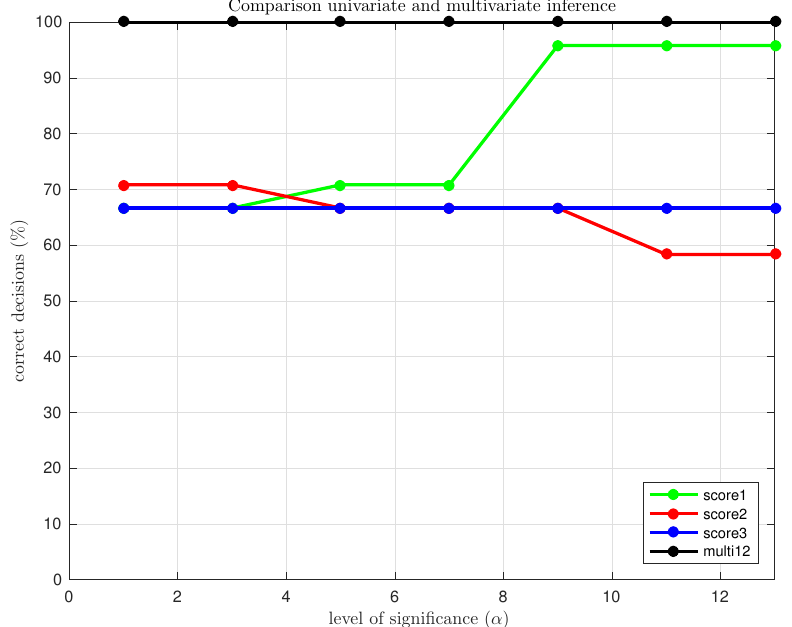
Figure 6. Percentage of correct decisions using the multivariate hypothesis testing fault detection strategy (scores 1 to 12, jointly) and the univariate hypothesis testing (for the first, second and third score), as a function of α